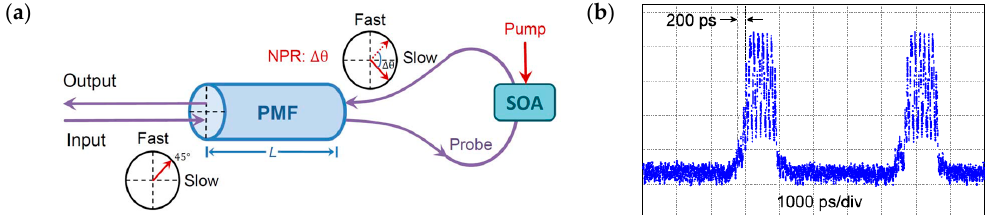
Figure 5. ( a ) Operation principle of the optically controlled Lyot loop filter. The pump laser and the work as an optically controlled polarization controller through ultrafast nonlinear polarization rotation effect. ( b ) Tuning speed measurement of the optically controlled microwave photonic dual-band filter. The filter is switching between the all-block and single-band